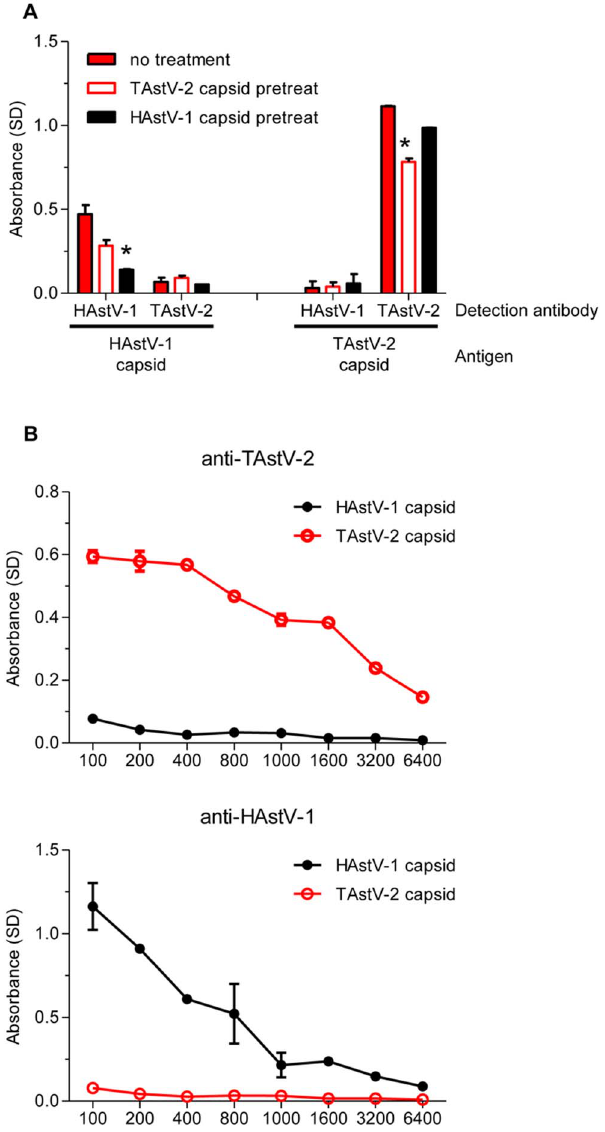
Figure 1. Development of a competitive astrovirus ELISA. A) Rabbit anti-HAstV-1 or TAstV-2 polyclonal antibodies were pre- incubated with PBS (no treatment) or purified recombinant HAstV-1 or TAstV-2 capsid proteins then tested for binding to bound HAstV-1 or TAstV-2 capsid protein by ELISA. *p , 0.05. B) Specificity of the rabbit polyclonal antibodies. Samples were run in at least duplicate and data are shown as mean values. Error bars indicate SD.